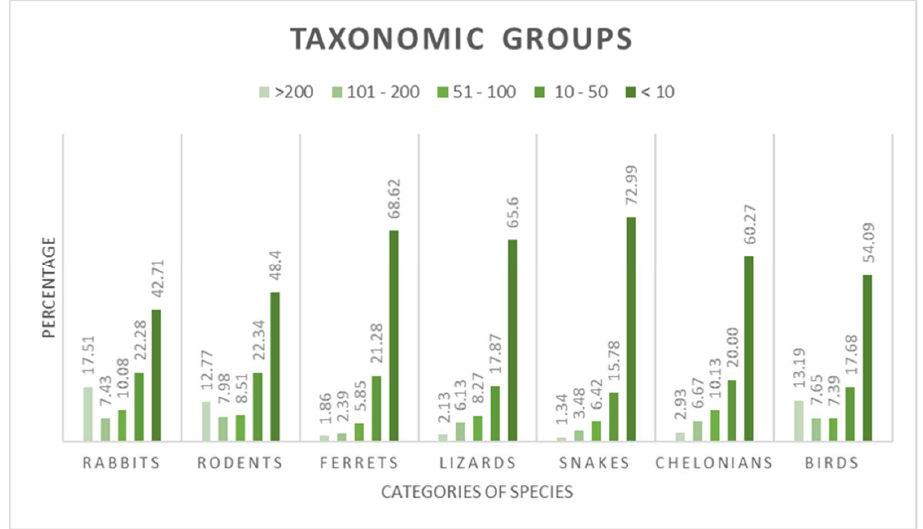
Figure 1. Relative exposure of the respondents ( n = 417) to non-conventional animals based on their species/taxonomic group. The percentages on the y -axis indicate the proportions of veterinarians participating to the study who reportedly performed anaesthesia in each specific species/categories of species. <10, 10–50, 51–100, 101–200 and > 200 are the number of animals, within each species/taxonomic group, anaesthetised per year by the respondents.